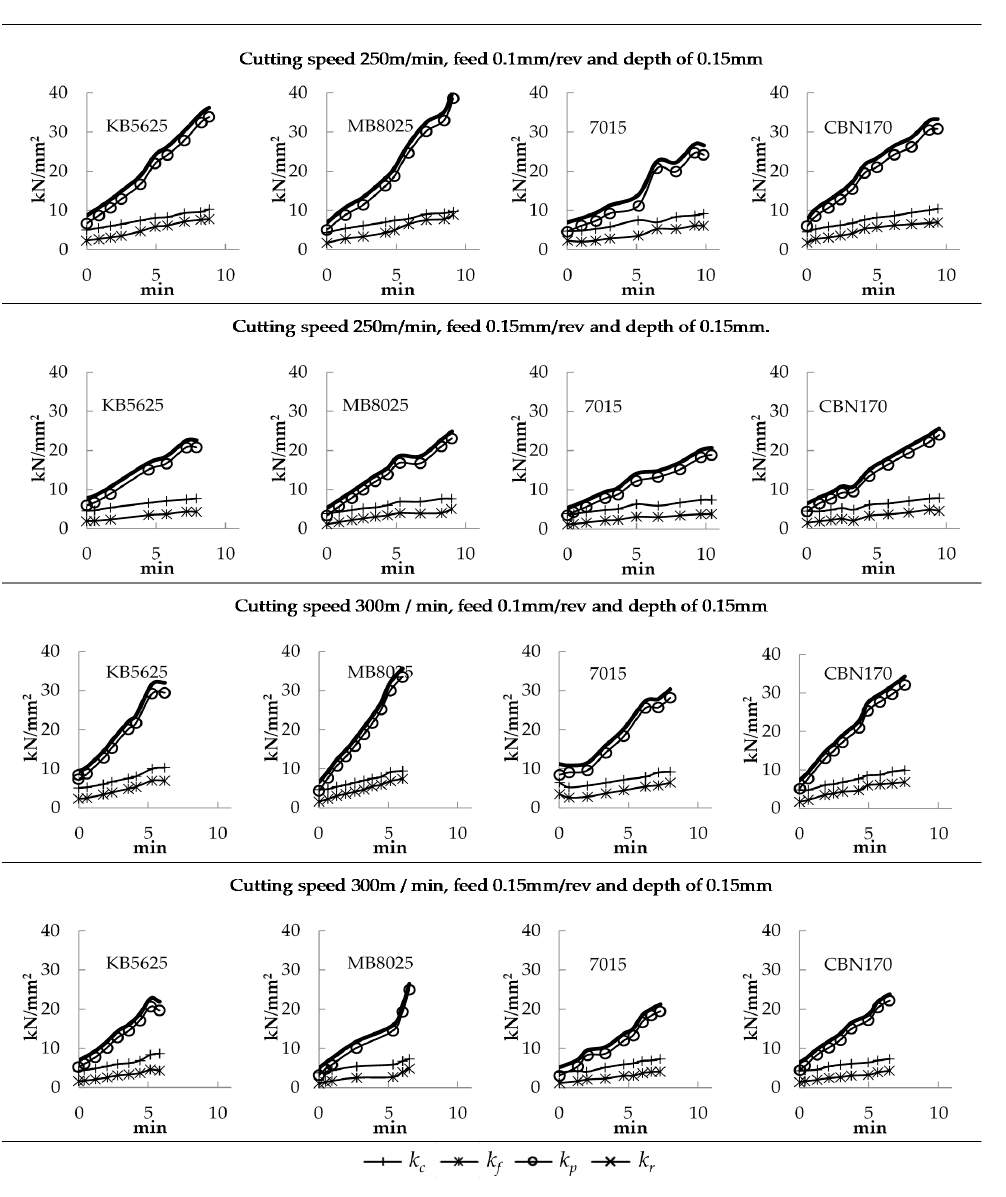
Figure 5. Evolution of the specific cutting forces (kN/mm 2 ) for the carbide tools.